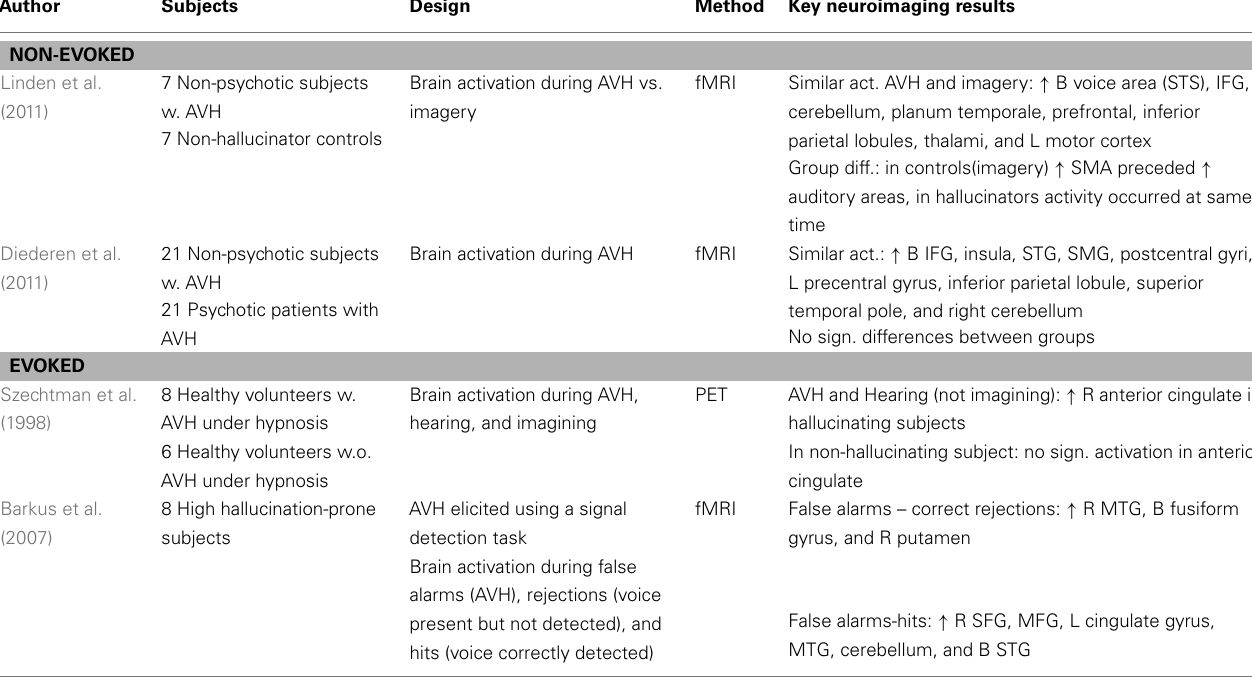
Table 1 | Symptome capture studies onAVH in non-psychotic